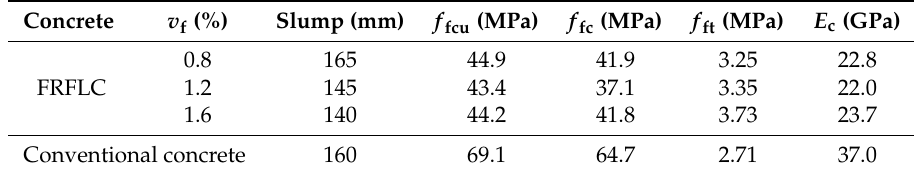
Table 1. Basic properties of steel fiber reinforced expanded-shales lightweight concrete (SFRFLC) and conventional